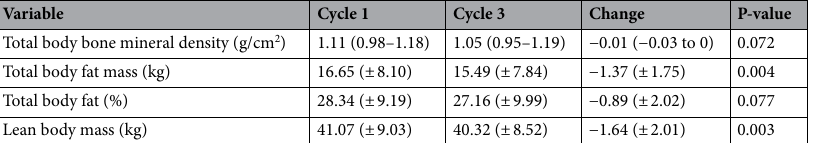
Table 3. Body composition from DEXA scan. Data are presented as mean (± standard deviation) or median (interquartile range) as appropriate. P-value is calculated by paired sample t-test or Wilcoxon signed-rank test as appropriate. 17 patients are included in analysis due to missing data at cycle 1 and/or cycle